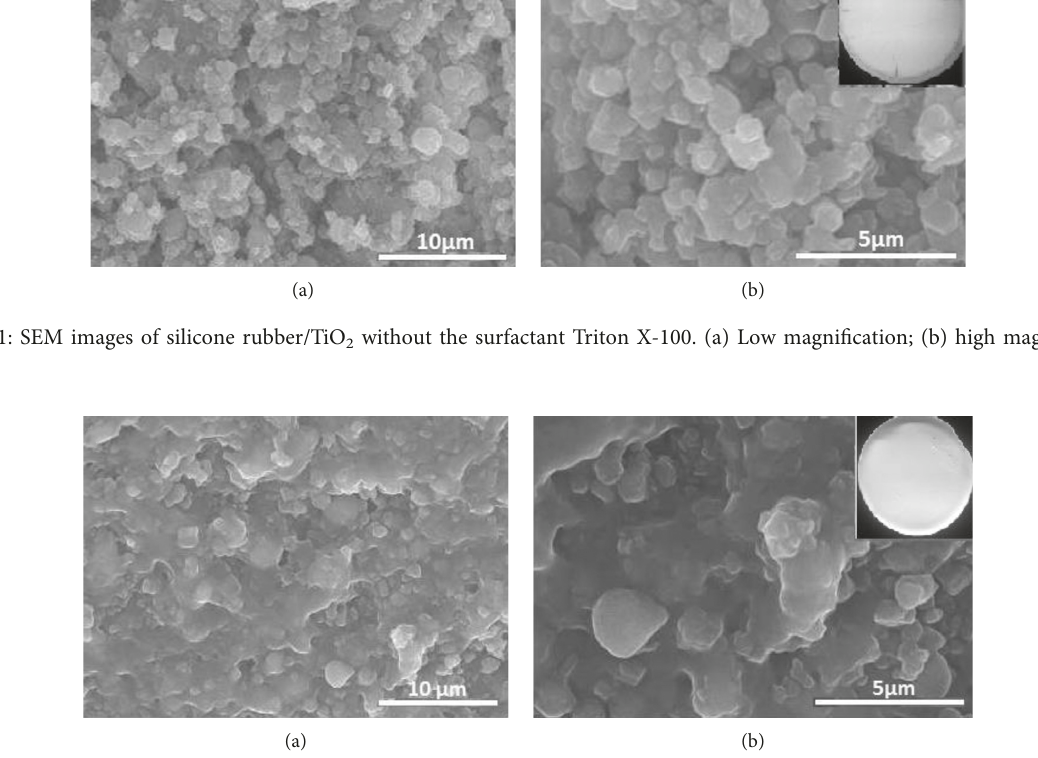
Figure 2: SEM images of silicone rubber/TiO 2 with Triton X-100. (a) Low magnification; (b) high magnification.